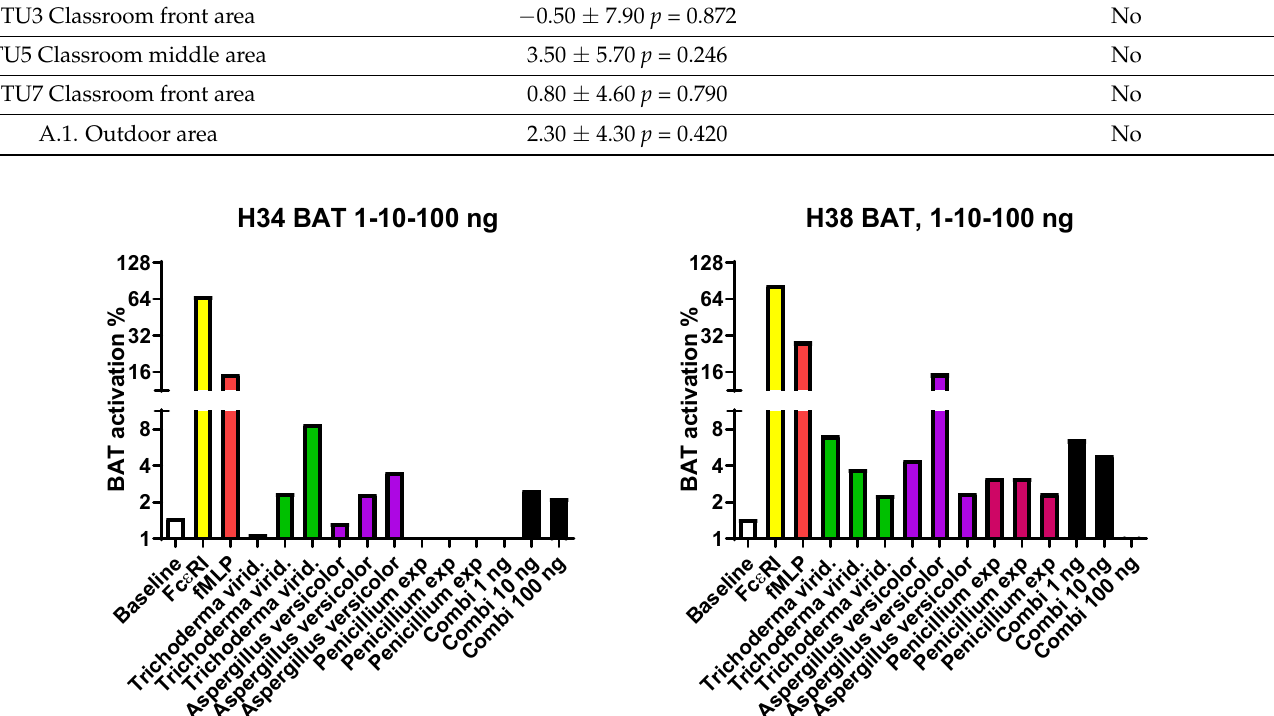
Figure 1. Result of two subjects’ positive basophil activation BAT tests: Baseline is without an activation stimulant. Fc ε RI is the IgE response positive control; fMLP is the non-IgE-mediated positive control. The pro- tein concentrations of the stimulating microbes used here were 1, 10, or 100 ng, respectively, from each strain tested. Combi signifies the combination of all three different strains; Combi 1 ng refers to each mold strain at a final concentration of 1 ng/tube, Combi 10 represents 10 ng/tube, and in Combi 100, the final concentration of all three strains was 100 ng/tube. A positive response can be considered when the BAT activation is about 2–3 times higher than that measured in the baseline tube. One exposed subject (H34) displayed an impressive dose response to Trichoderma , while for the other exposed subject (H38) the same doses became too toxic. This figure presents only those two exposed subjects in whom the stimulation reaction to a mold was positive. In all the other ex- posed subjects, results with the six mold strains examined in this study showed no evidence of ba- sophil activation. 3.4. Studies of the Ig Levels in Serum and Fecal Samples Therefore, studies were proceeded to evaluate the systemic and intestinal immuno- logical status of the study persons using these six different mold strains by examining serum and fecal antibodies (immunoglobulins, Igs, Figures 2–5). Determination was per- formed to evaluate if the exposed differed in their Ig responses in comparison to controls.